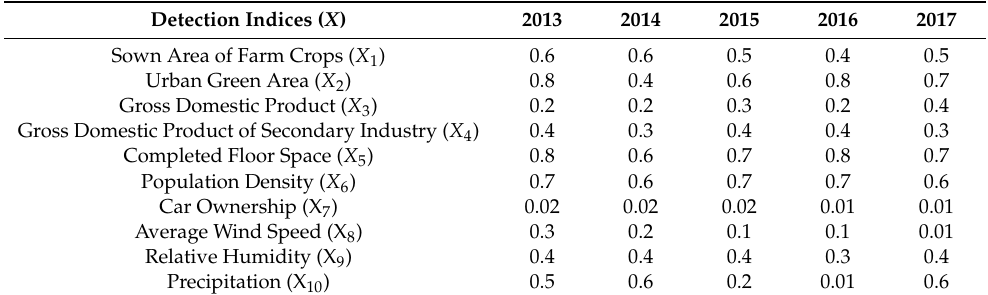
Table 3. Geographic detector results for PM 2.5 for BTH from